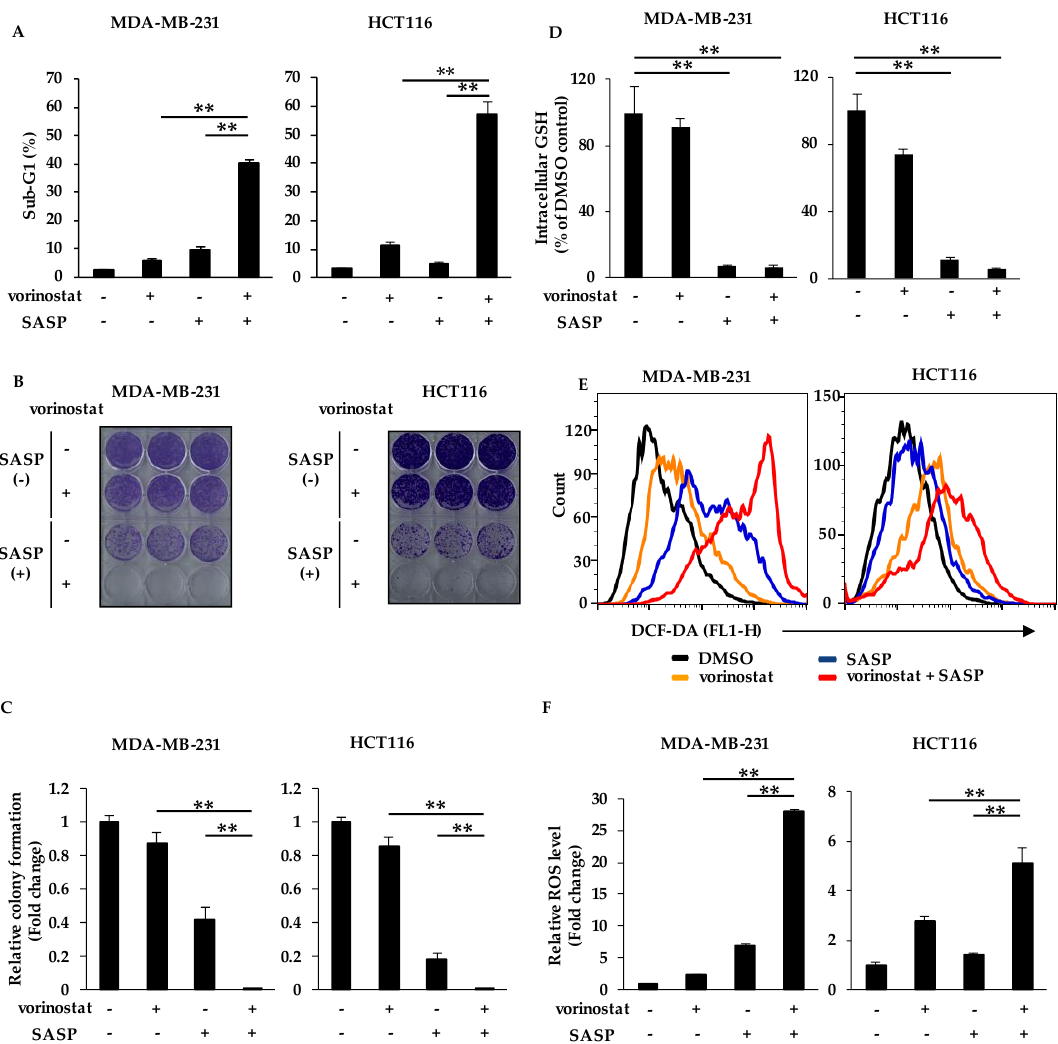
Figure 4. Salazosulfapyridine (SASP) increases sensitivity to vorinostat by reducing intracellular GSH levels and ROS accumulation. ( A ) Flow cytometry analysis of cell death induced by cotreatment of vorinostat with SASP. MDA-MB-231 and HCT116 cells were treated with 1.6 µ M vorinostat, 500 µ M SASP, or a combination of both for 144 h. The percentages of cells in the sub-G1 population were analyzed by flow cytometry. Columns, means ( n = 3); bars, SD. ** p < 0.01. ( B , C ) Colony formation of cells cotreated with vorinostat and SASP. MDA-MB-231 and HCT116 cells were treated with 1.6 µ M vorinostat, 500 µ M SASP, or a combination of both for 144 h, and then the media were replaced. After the cells were cultured for 3–7 more days, the colonies were stained with crystal violet. Representative images of colony formation ( n = 3) are shown ( B ). Colony formation was quantified using ImageJ ( C ). The data obtained with DMSO control were taken as 1. Columns, means ( n = 3); bars, SD. ** p < 0.01. ( D ) Measurement of intracellular glutathione (GSH) levels in cells cotreated with vorinostat and SASP. MDA-MB-231 and HCT116 cells were treated with 1.6 µ M vorinostat, 500 µ M SASP, or a combination of both for 24 h, and then subjected to the intracellular GSH content assay. The data obtained with DMSO control were taken as 100%. Columns, means ( n = 3); bars, SD. ** p < 0.01. ( E , F ) Flow cytometry analysis of ROS levels in cells cotreated with vorinostat and SASP. MDA-MB-231 and HCT116 cells were treated with 1.6 µ M vorinostat, 500 µ M SASP, or a combination of both for 48 h. Representative histogram patterns of ROS levels are shown ( E ). The amount of ROS in cells was detected by CM-H2DCFDA using a flow cytometer ( F ). The data obtained with DMSO control were taken as 1. Columns, means ( n = 3); bars, SD. ** p < 0.01.